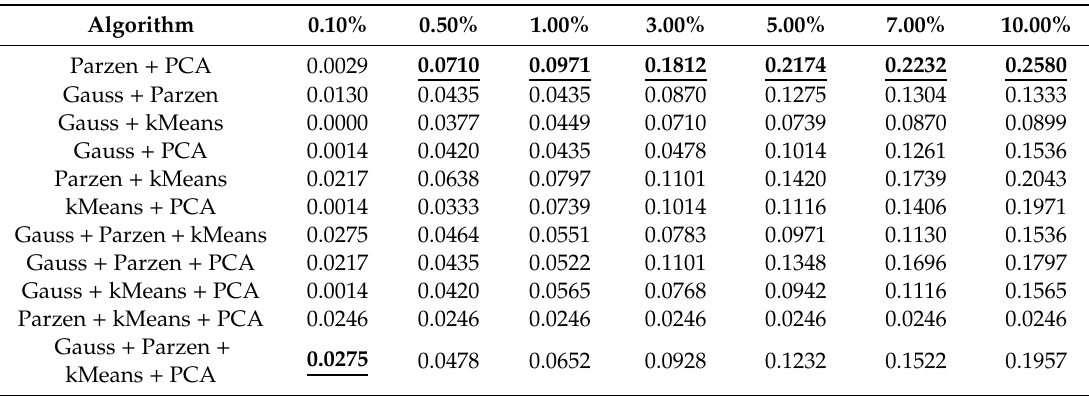
Table A5. True detection rate of each anomaly detection algorithm based on the daily activity summary dataset (IT Admin). Best performance is shown in bold and underlined.